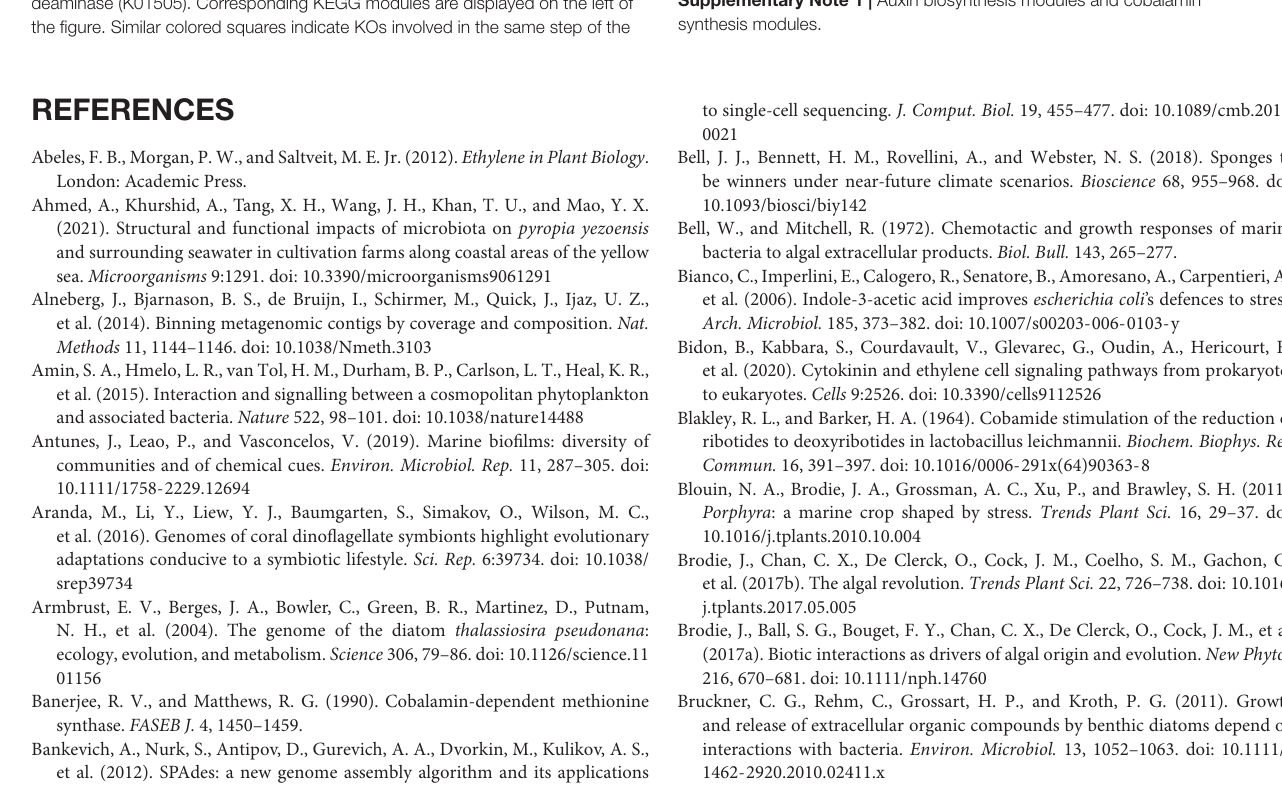
Supplementary Table 1 | Taxonomy and statistics of the IMG/M database with Pyropia symbiont genomes included in the concatenated marker gene tree. The GTDB R89 taxonomy is presented. Supplementary Table 2 | Taxonomy and statistics of 202 MAGs retrieved from this study. The GTDB R89 taxonomy is presented. Supplementary Table 3 | KO count for each of the 202 MAGs retrieved in this study. The GTDB R89 taxonomy is presented. KOs are involved in the described metabolic pathways (i.e., carbon fixation, nitrogen, sulfur, phytohormone, and vitamin B 12